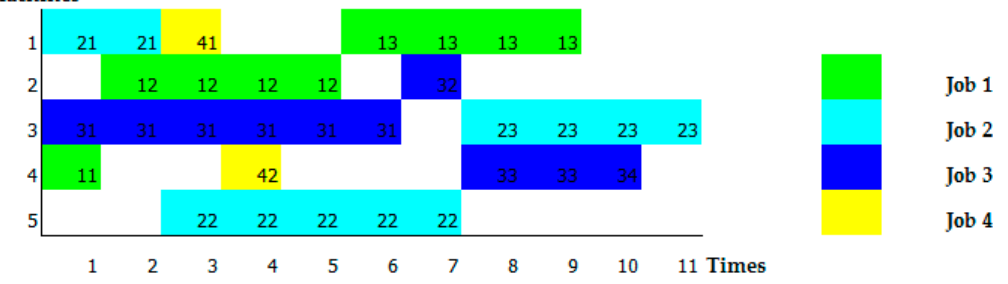
Figure 7. Gantt chart of solutions to flexible job shop scheduling problem K01 presented by Kacem et al. [26,27].